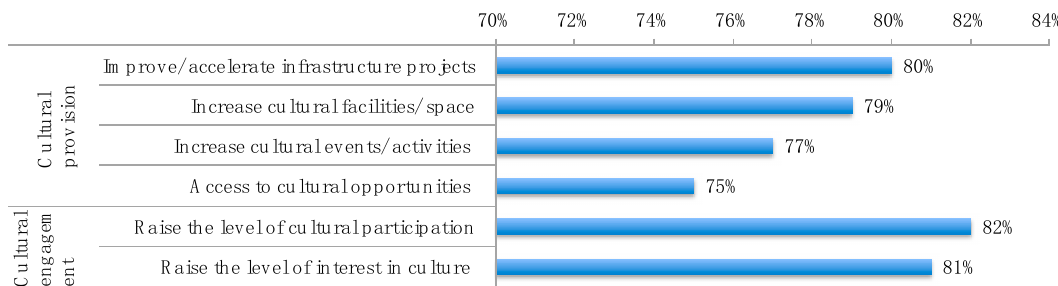
Figure 2. Perceptions of residents about the cultural provision and engagement effects of Liverpool 2008. Note: This is the 2015 neighbourhood survey, n = 592; number = % of agreement.